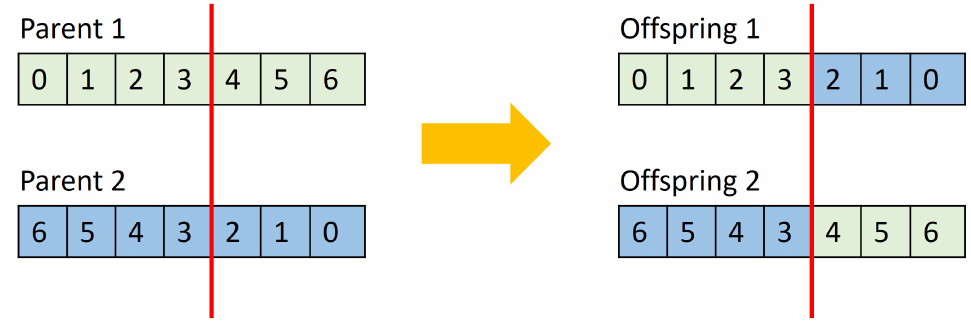
Figure 1. Single point